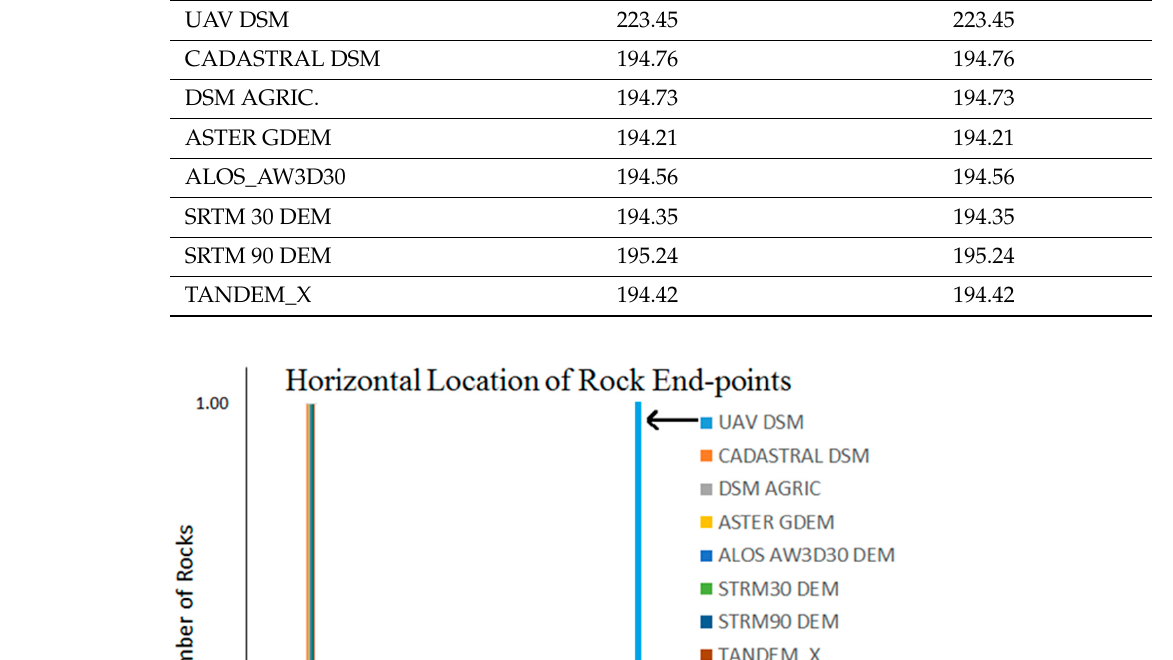
Table 11. Horizontal location of rock end points for the 2nd slope profile. Slope Profile 2